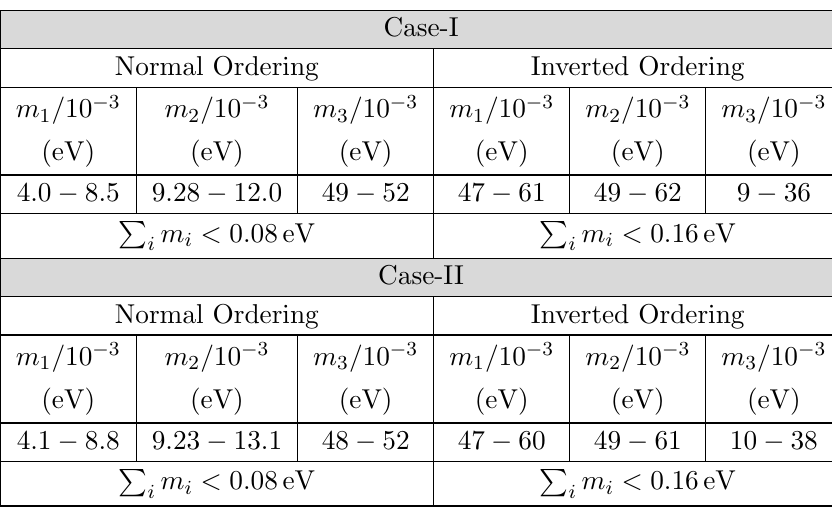
Table 3 . Predictions on the light neutrino masses and P